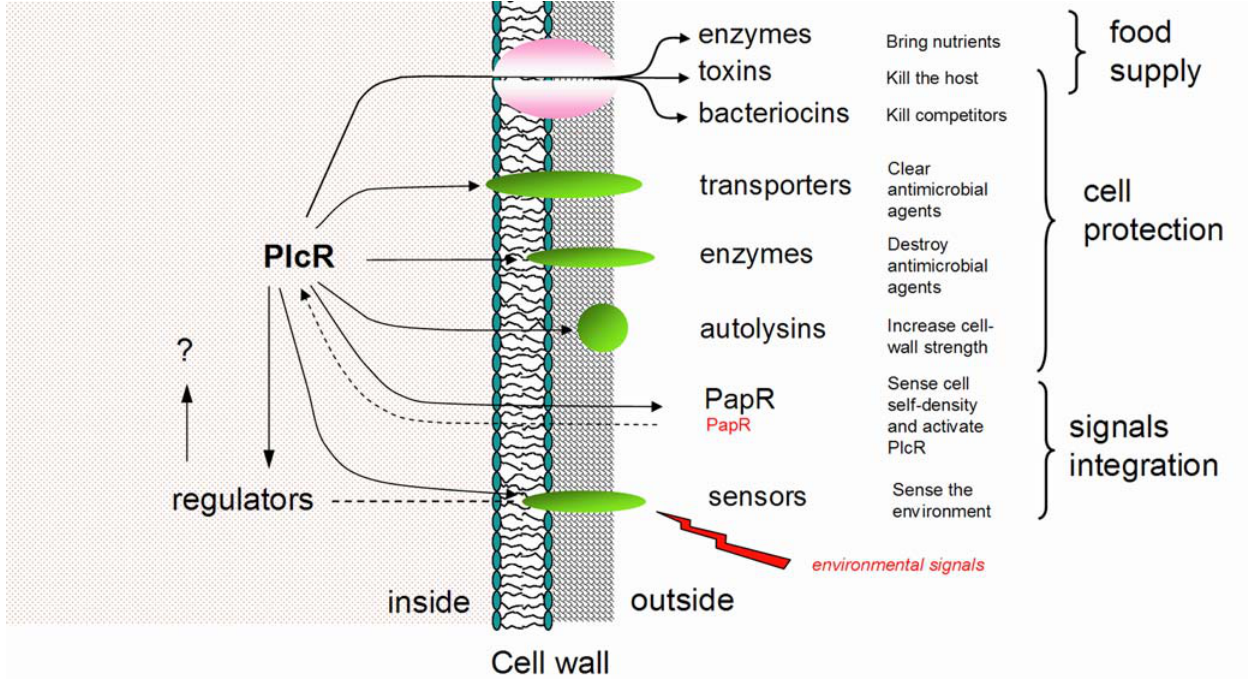
Figure 5. Overview of the PlcR regulon organization. PlcR positively controls (dark line) the transcription of a vast array of genes coding for proteins located in the cell wall or in the extracellular space. Cell wall proteins are designed in green. Secreted proteins are exported through the SecA machinery designed in pink. Environmental signals are sensed by cell-wall sensors and act via (dashed line) regulators on undetermined genes or proteins. PlcR requires PapR to be active (dashed line). Signals integrated by PlcR and PlcR-controlled regulators are designed in red.